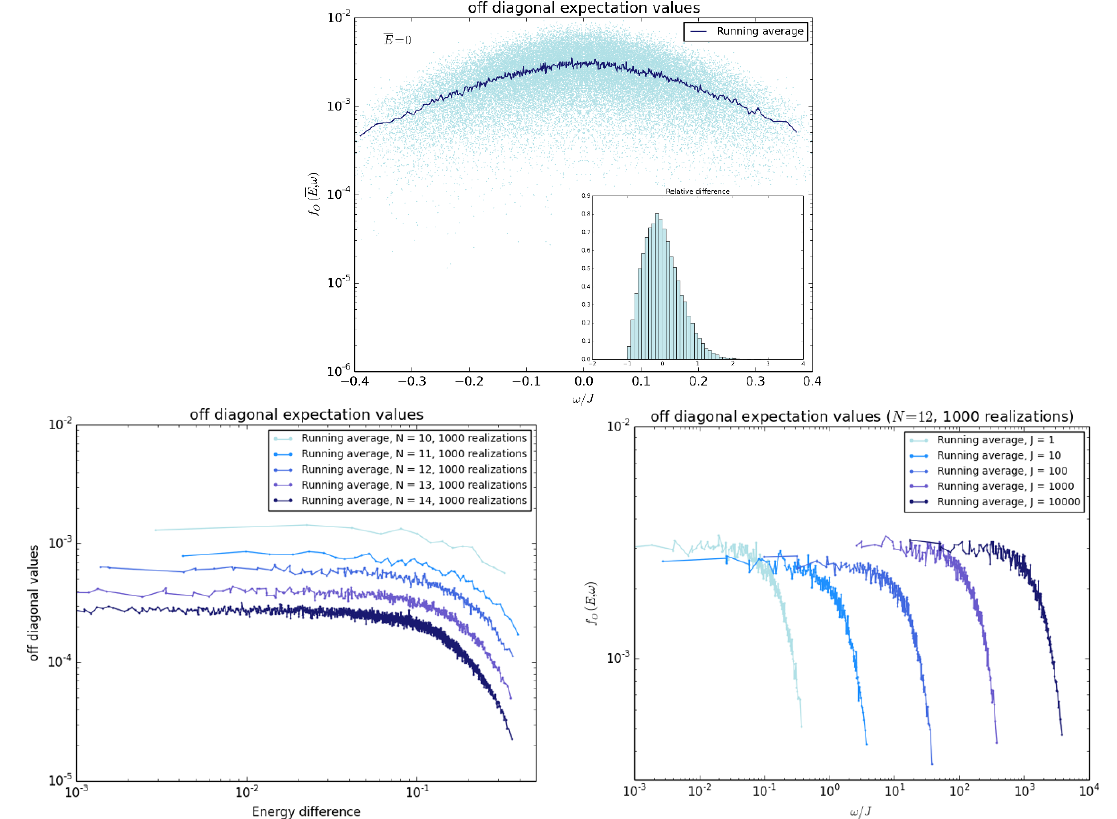
Figure 3 . O(cid:11)-diagonal values of matrix elements O nm = jh n jOj m ij for the single-site number operator O = ^ n N at half (cid:12)lling (cid:23) = 1 . We show the o(cid:11)-diagonal matrix elements against their 2 energies E n =J . Top panel : N = 14 with raw data in light blue and the running average in dark blue. The inset shows a histogram of relative error between raw data and running average. We see that the histogram is peaked around zero. Left panel: the function f O ( (cid:22) E; ! ) (we show the running average) for varying Hilbert space dimension corresponding to N = 10 ; 11 ; 12 ; 13 ; 14. The cross-over from constant to non-constant behavior is identi(cid:12)ed with the Thouless energy E T . Right panel: scaling of the Thouless energy with average coupling strength J . A simple (cid:12)t gives E T / J 2 .